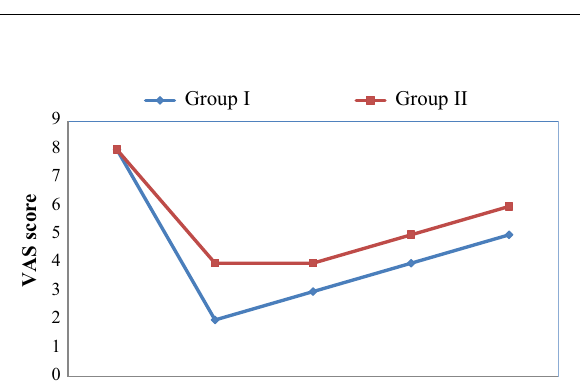
Fig. 1 Changes of the VAS score pre block, 2 h, 2 days, 2 weeks and 4 weeks post block in the two studied groups